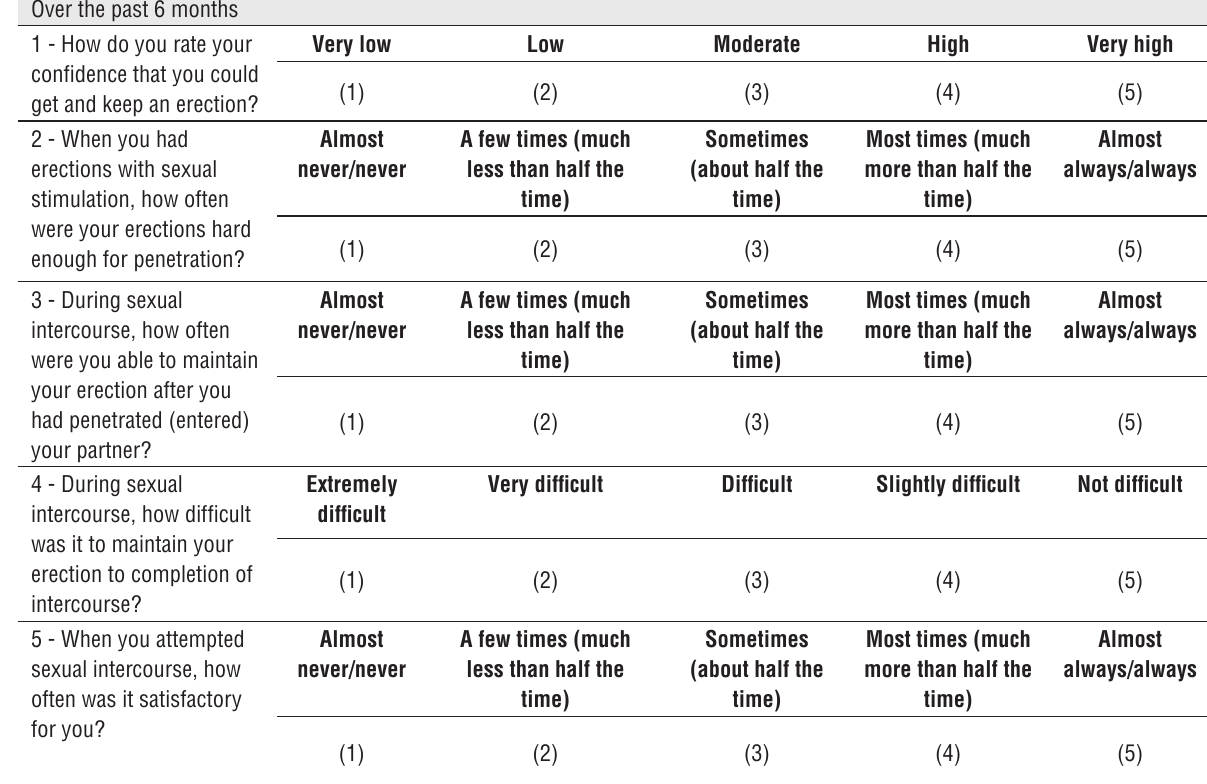
Table 2 - The International Index of Erectile function (IIEf-5) Questionnaire (8, 13). Table 1 - sample data of the animals submitted to thermoablation using radiofrequency. Over the past 6